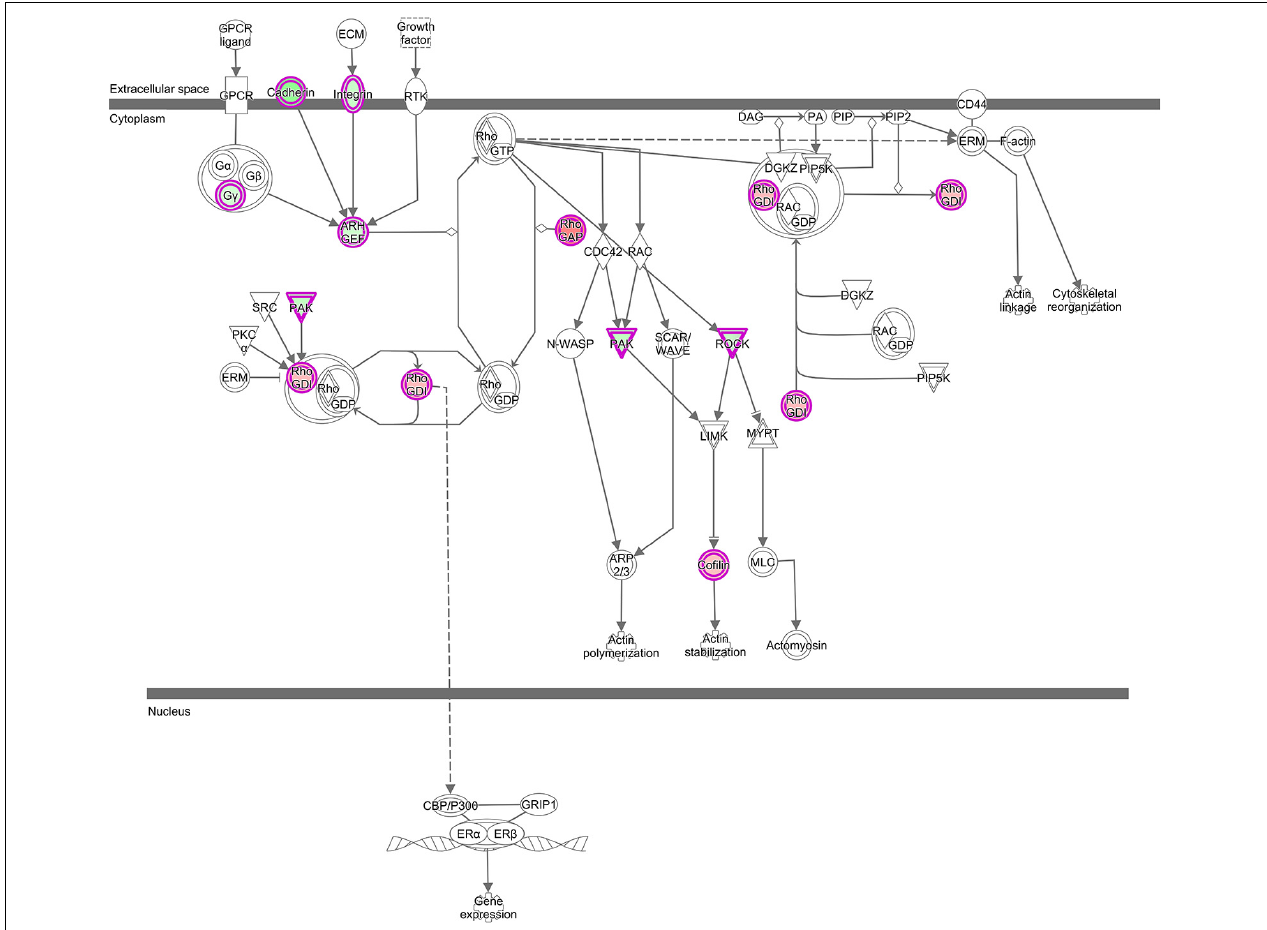
FIGURE 6 | “RhoGDI Signaling canonical pathway” from IPA, was the top enriched pathway with genes from GNM ‘yellow’ with z -score = 2.33. This figure is adapted from Ingenuity Pathway Analysis R (cid:13)